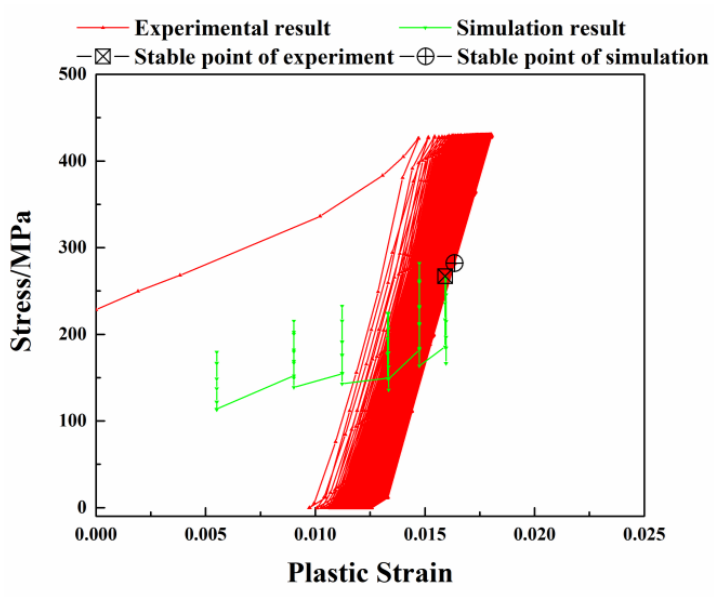
Figure 20. Simulation and experimental cyclic stress-strain curves.